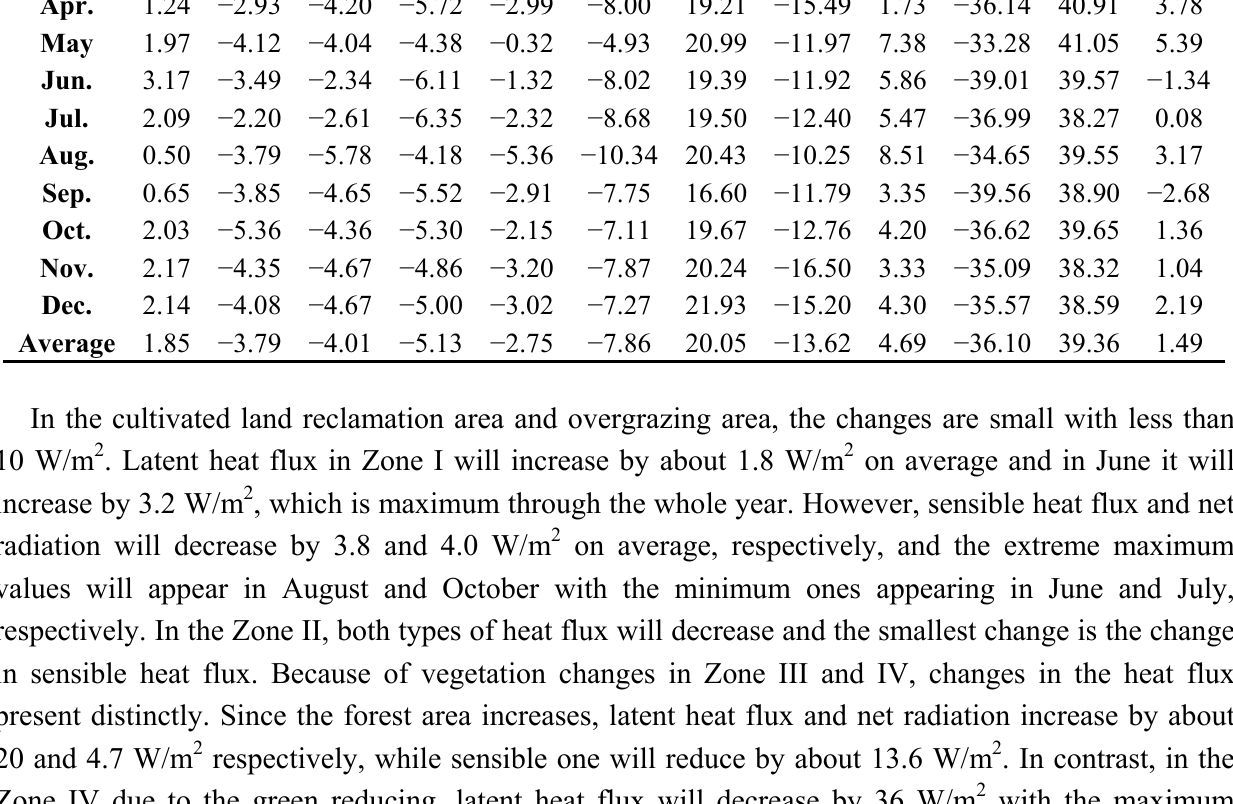
Table 1. Monthly average changes of latent heat flux ( LH ), sensible heat flux ( H ) and net ) in the grids with LUCC from 2010 to 2050 (Unit: W/m 2 ). radiation ( R n